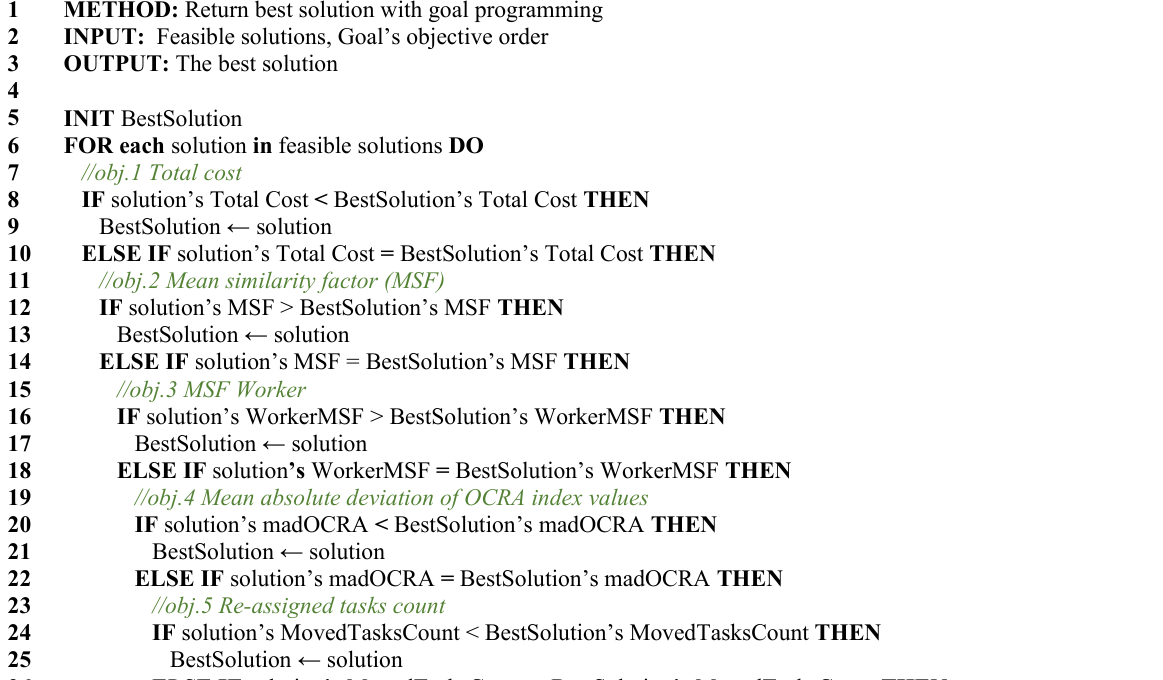
Algorithm 3: The preemptive goal programming algorithm (for Goal 1)